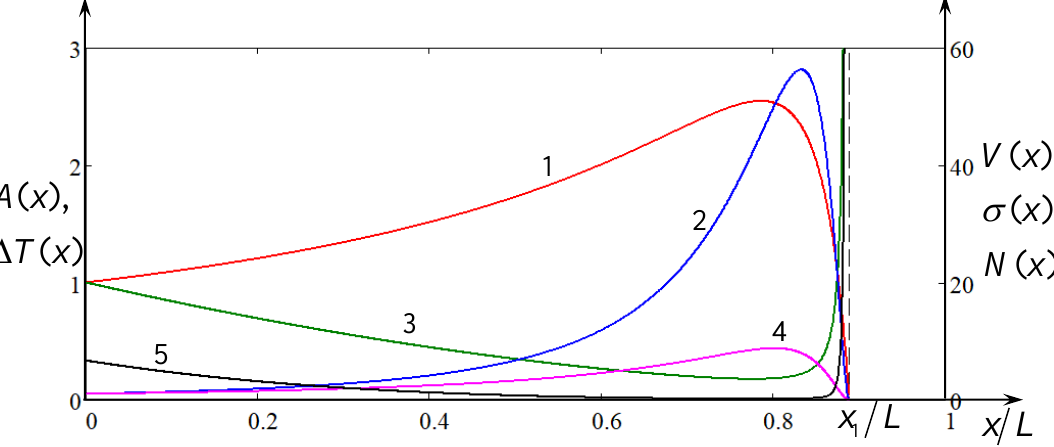
Figure 4. (Color online) Variations with the distance of normalised soliton amplitude A ( x ) / A ( 0 ) (line 1), velocity V ( x ) / V ( 0 ) (line 2), duration ∆ T ( x ) / ∆ T ( 0 ) (line 3), carrier wave period T c ( x ) / T c ( 0 ) (line 4), and the number of carrier wave periods on the half-duration N ( x ) (line 5) when a soliton moves towards the shore with the linearly decreasing depth, as shown in Figure